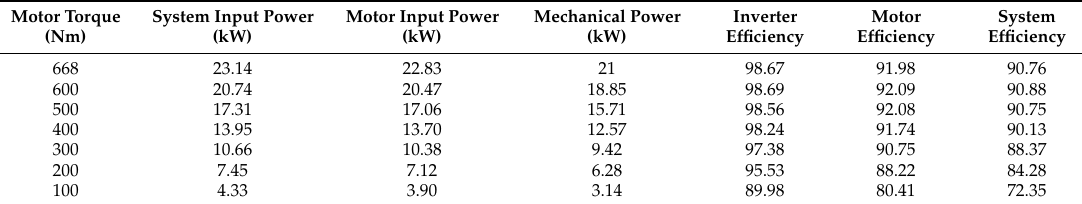
Table 9. Experimental results of the SiC-MOSFETs-based PMSM drive system in the rated speed by the MTPA control.